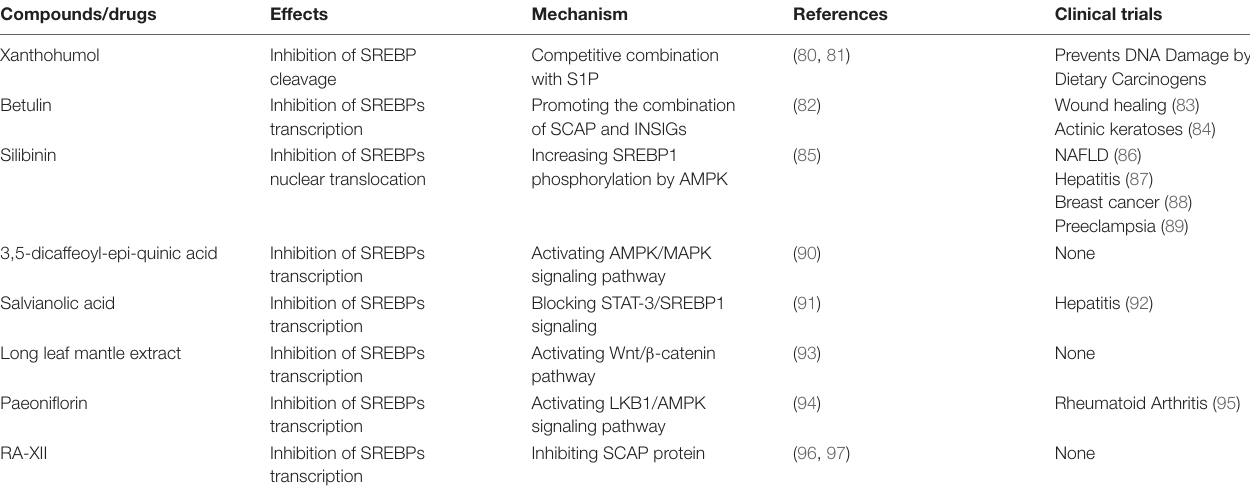
TABLE 2 | Natural drugs targeting SREBPs and their mechanism of